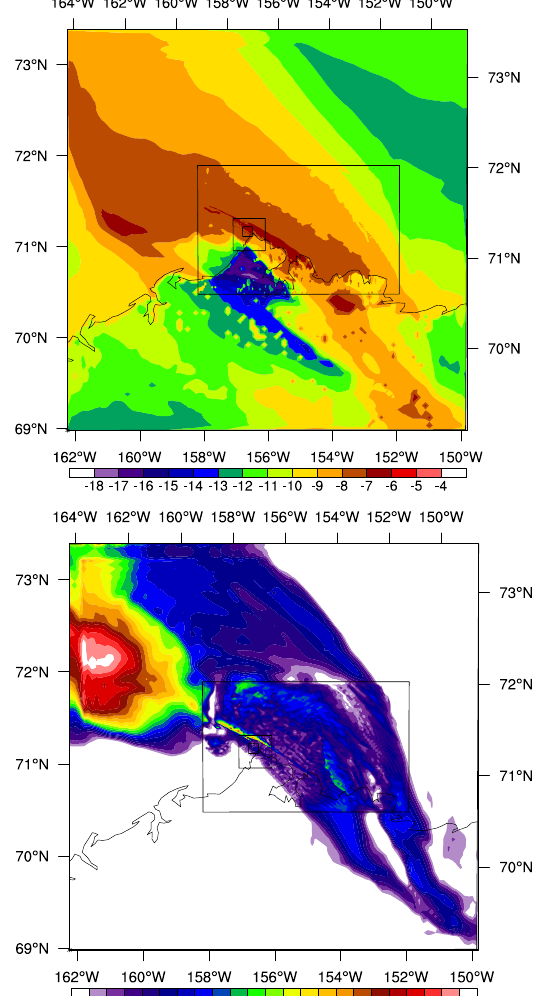
Fig. 4. Surface skin temperature (top) and liquid water path (bot- tom), in units of ◦ C and gm − 2 , respectively, at 20Z 8 April 2008 for the 50m, 200m, 1km and 5km nests. Barrow, Alaska is located directly to the east of the 50m nest southeast